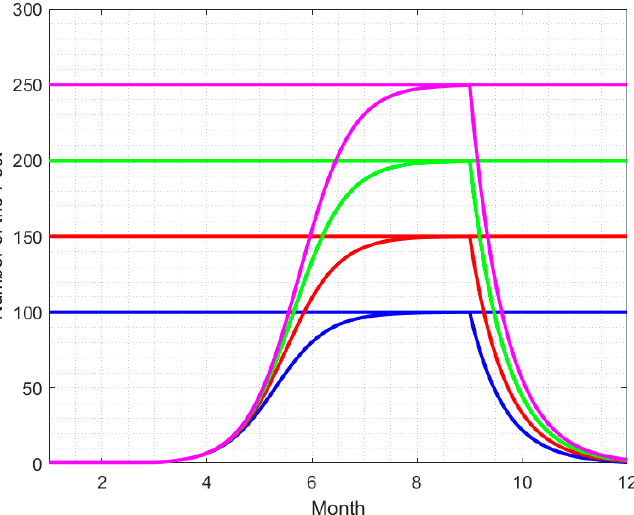
Figure 9. Changes in hornet population. Note:The four different colored lines correspond to four different maximum numbers of bumblebee